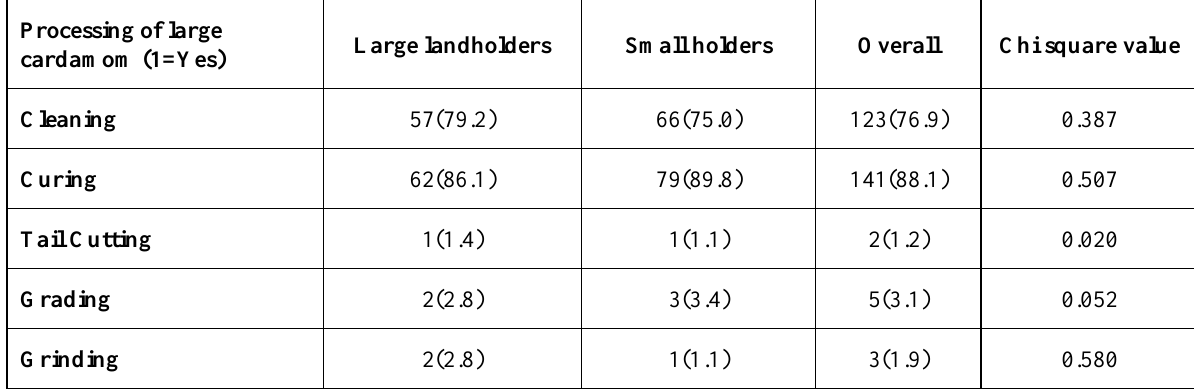
Table 5. Post-harvest management of the large cardamom